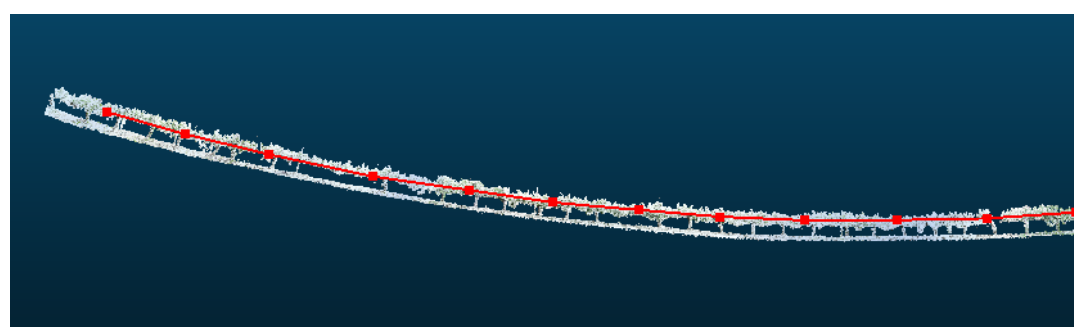
Figure 4. Part of the model line of the 3D reconstruction of Figure 2.